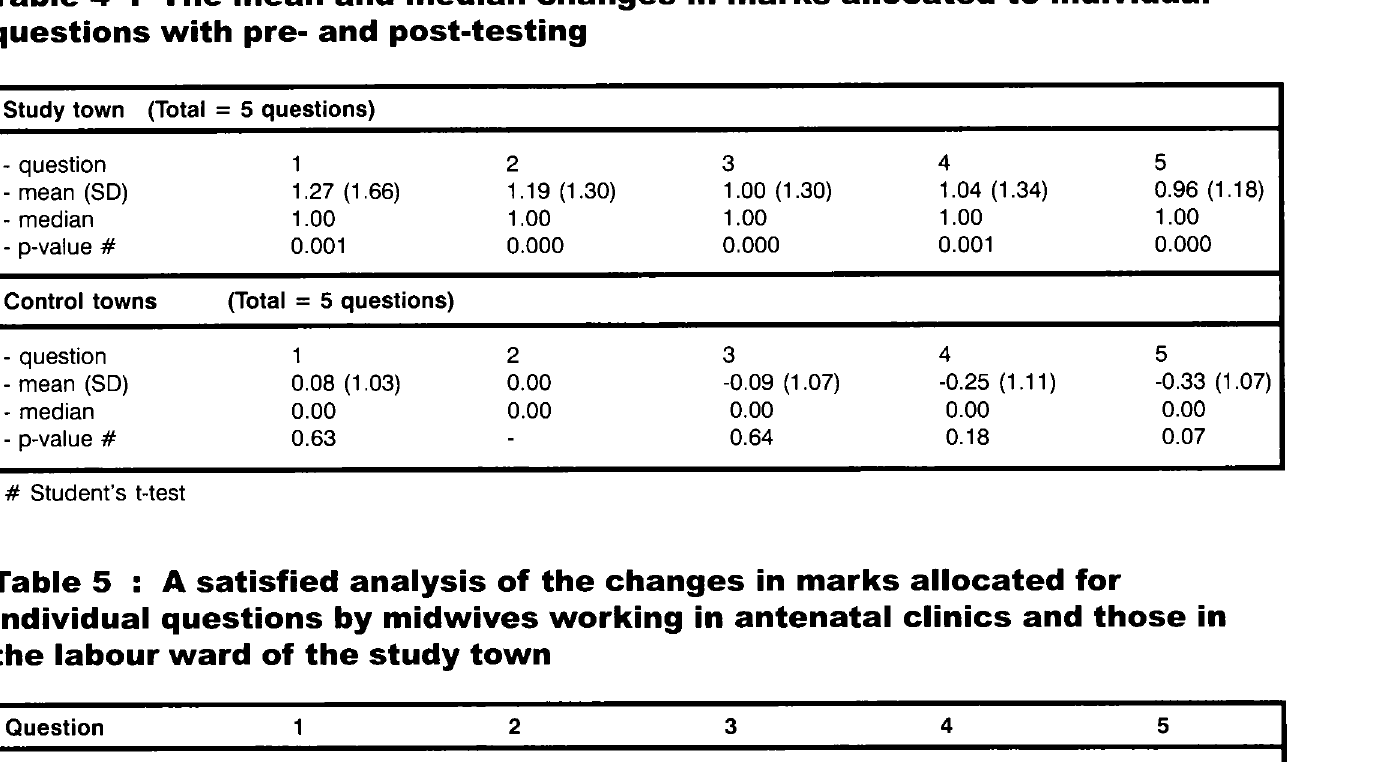
Table 6 : The shift in m arks of individual m idwives for whom paired observations w ere